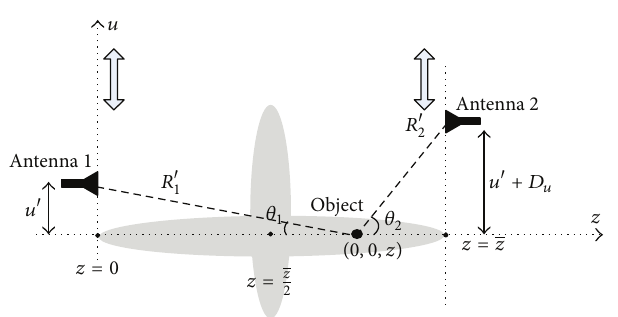
Figure 2: Simplifying the 3D setup in Figure 1 to a 2D setup for deriving resolution limits in terms of 𝜃 1 and 𝜃 2 . When 𝐷 𝑢 = 0 , the range resolution is poor in the shaded region. The grey thick arrows show the directions of the